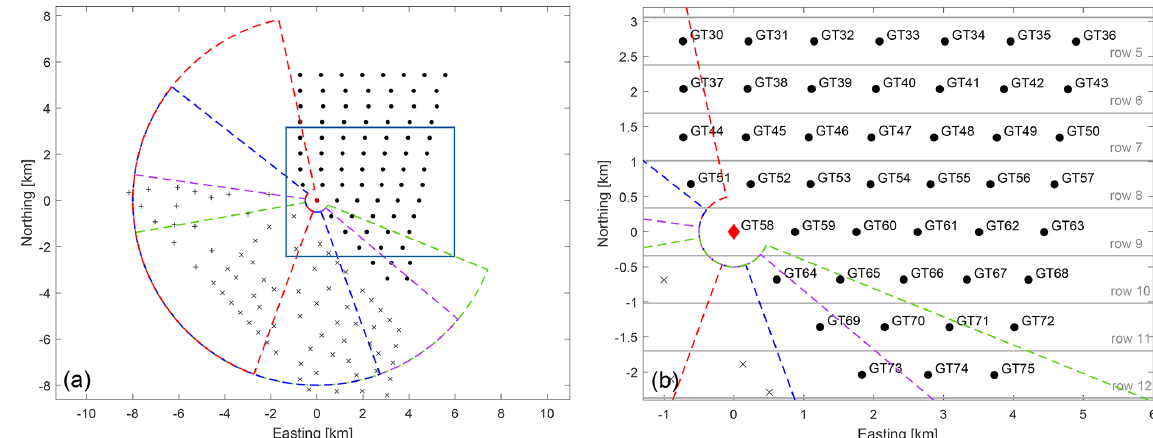
Figure 1. Layout of the wind farm Global Tech I with turbine positions visualized as black dots. Further, the neighbouring wind farms Albatros ( + ) and Hohe See ( × ) are shown. The lidar location is depicted as a red diamond and lidar trajectories as coloured dashed lines. The Cartesian grid is centred around the lidar’s position. Grey horizontal lines mark turbine rows referred to in this work. The blue rectangle indicates the zoomed-in region shown on the right. It displays turbine numbers of the wind farm’s centre region.